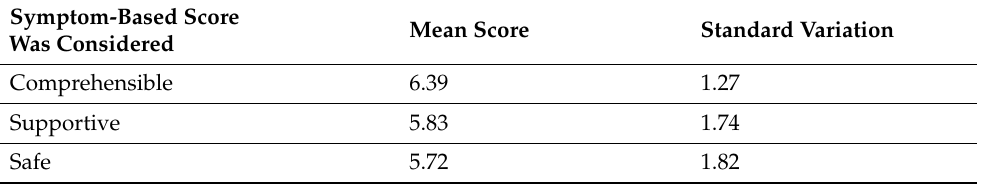
Table 5. Patient satisfaction with the symptom-based scoring system. Forty-six patients rated on scales (1–7 points), whether they found the score comprehensible, supportive, and safe. Higher scores represent higher degrees of